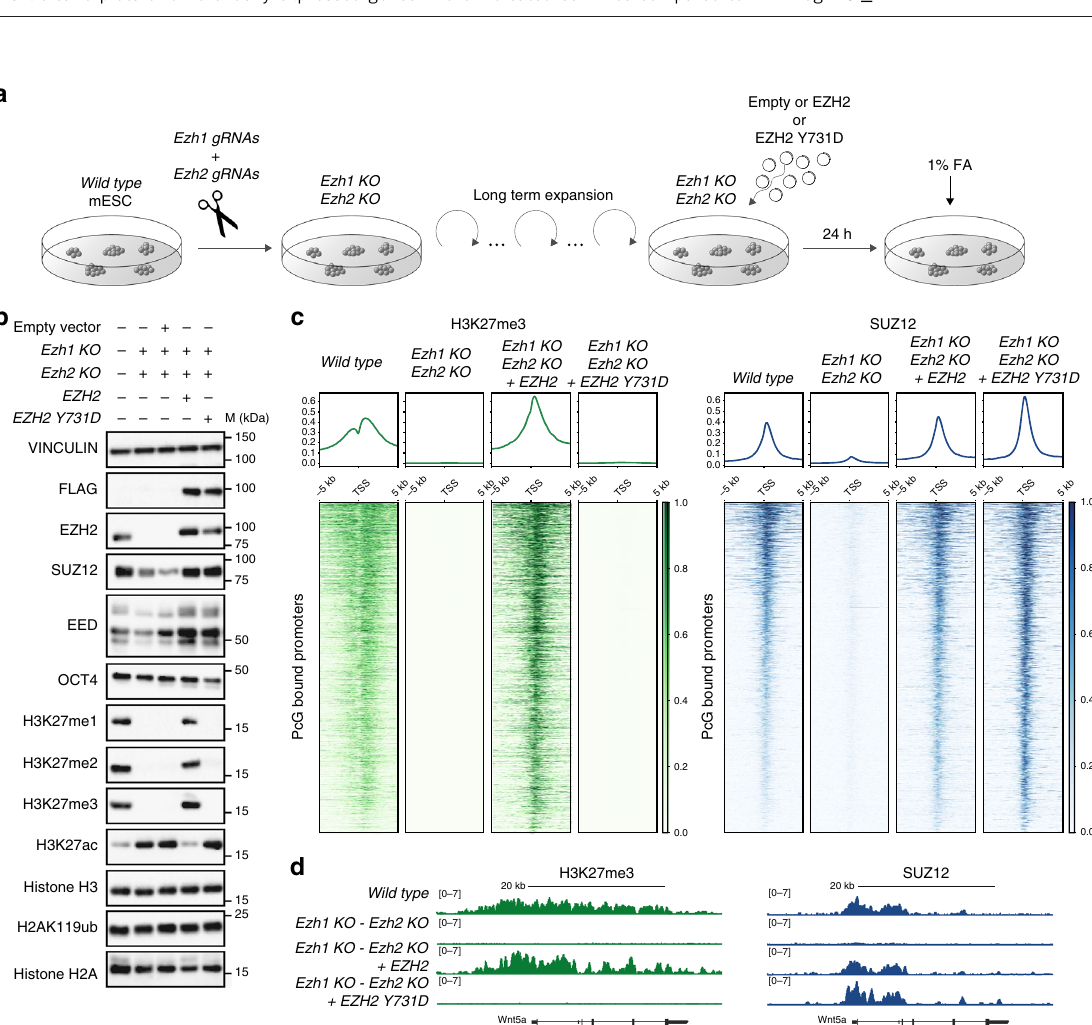
Fig. 2 PRC2-EZH1 is unable to spread H3K27me3 deposition but preserves target genes repression. a Illustration describing the criteria used to select SUZ12 inside peak regions, its boundaries, and the regions selected for the analysis at the 5 ′ and 3 ′ outside SUZ12 peak boundaries. b Boxplots representing H3K27me3 density distribution in WT and Ezh2 KO cells within PRC2 peaks, as well as 1.2 kb outside the 5 ′ and 3 ′ ends. P -values were determined using a Student ’ s t -test. c Left panels, boxplots representing the distribution of the H3K27me3 density ratio between the H3K27me3 density inside PRC2 peaks (PEAK in a ) and at 5 ′ (left panel) or 3 ′ (right panels) spreading regions (5 ′ or 3 ′ spread in a ). P -values were determined using a Student ’ s t -test. Right panels, the correlation for the IN/OUT H3K27me3 density ratio between WT and Ezh2 KO cells. The linear correlation coef fi cient ( r ) and coef fi cient of determination ( r 2 ) are shown in the graphs. d Left panels, boxplots representing the distribution of the H3K27me3 density ratio between the H3K27me3 density inside PRC2 peaks (PEAK in a ) and at 5 ′ (left panel) or 3 ′ (right panels) spreading regions (5 ′ or 3 ′ spread in a ) considering the top 20% H3K27me3 enriched promoters in Ezh2 KO cells based on P -values. P -values were determined using a Student ’ s t -test. Right panels, the correlation for the IN/OUT H3K27me3 density ratio between WT and Ezh2 KO cells. The linear correlation coef fi cient ( r ) and coef fi cient of determination ( r 2 ) are shown in the graphs. e Volcano plots of differentially expressed genes in the indicated cell lines compared to WT. Log2FC ≥ 1